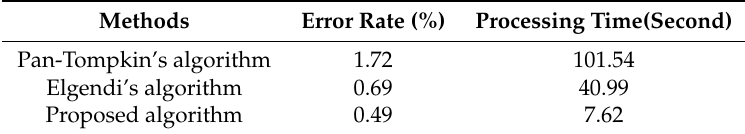
Table 7. Comparison of processing time for NSRDB of Elgendi’s Algorithm and the proposed work running on